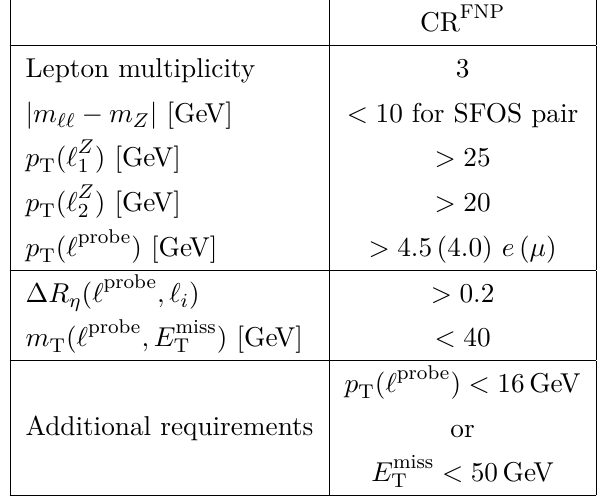
Table 5 . FNP selection. Detailed definition of the CR FNP